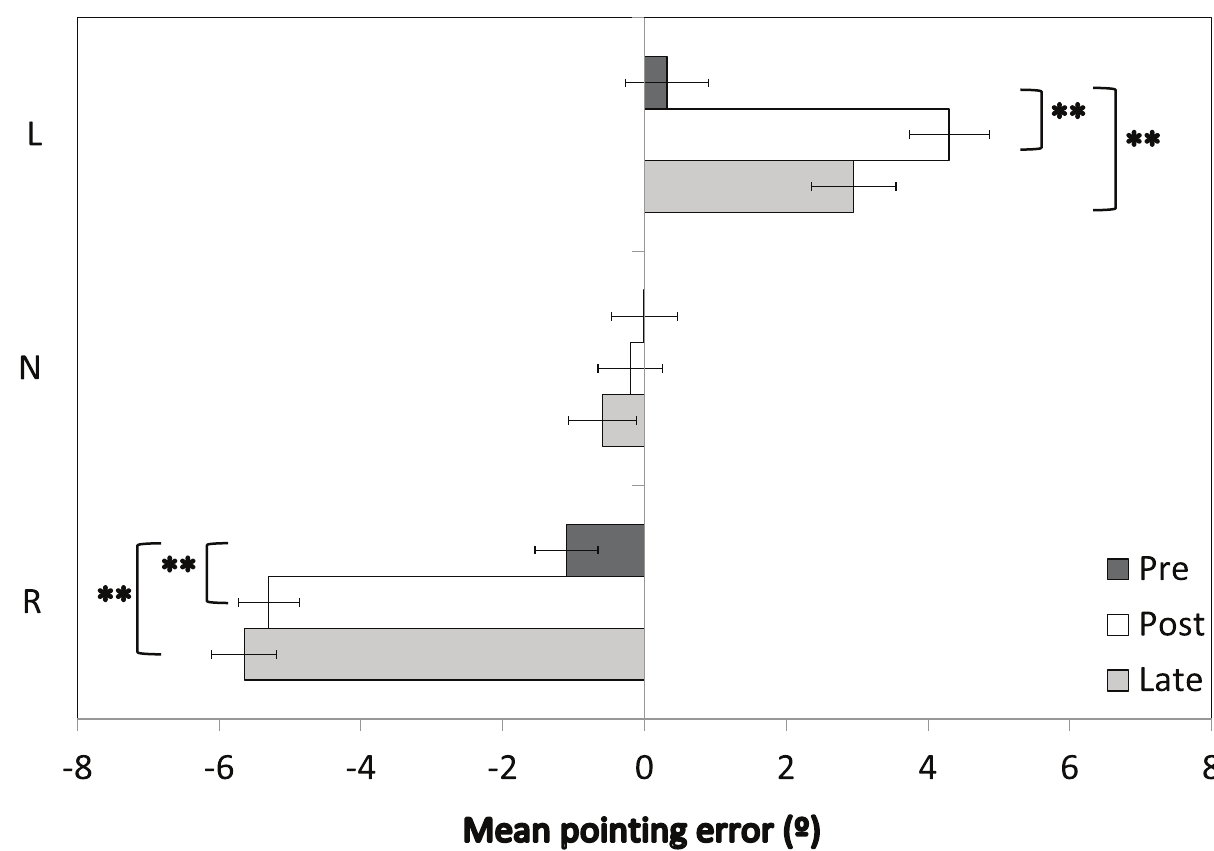
Figure 4. Open loop pointing errors. Horizontal pointing errors (°) are shown for the Group × Session interaction. L = leftward-shifting; N = neutral pointing; R = rightward-shifting. Error bars indicate ±1SEM; ** indicates p